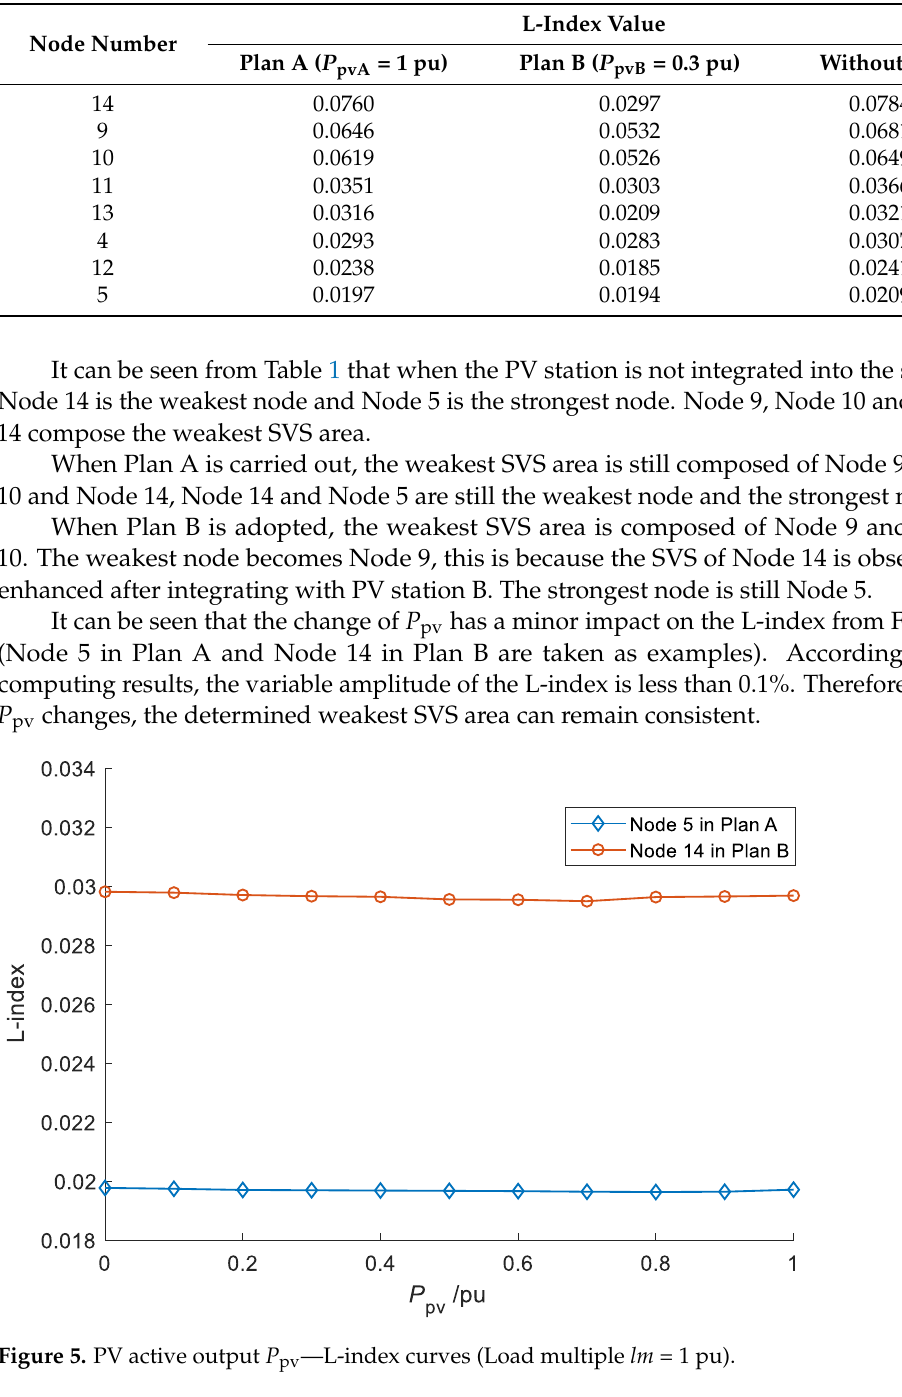
Table 1. L-index values of load nodes under Plan A and Plan B (Load multiple lm = 1 pu).